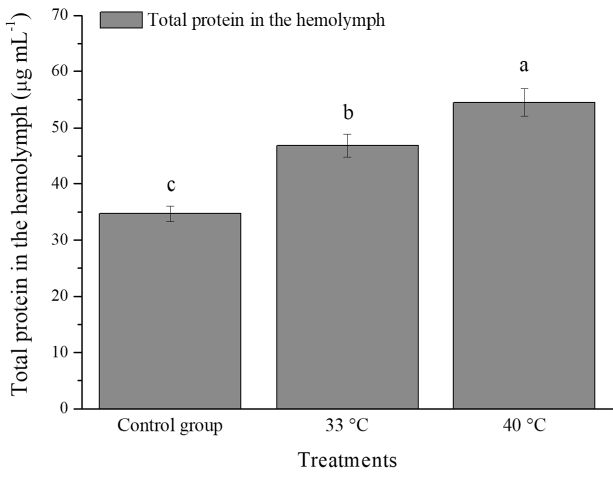
Fig 4 . Total protein content in the hemolymph of 12-day-old bees at different treatment temperatures. Different letters indicate a significant difference (Tukey test, p <